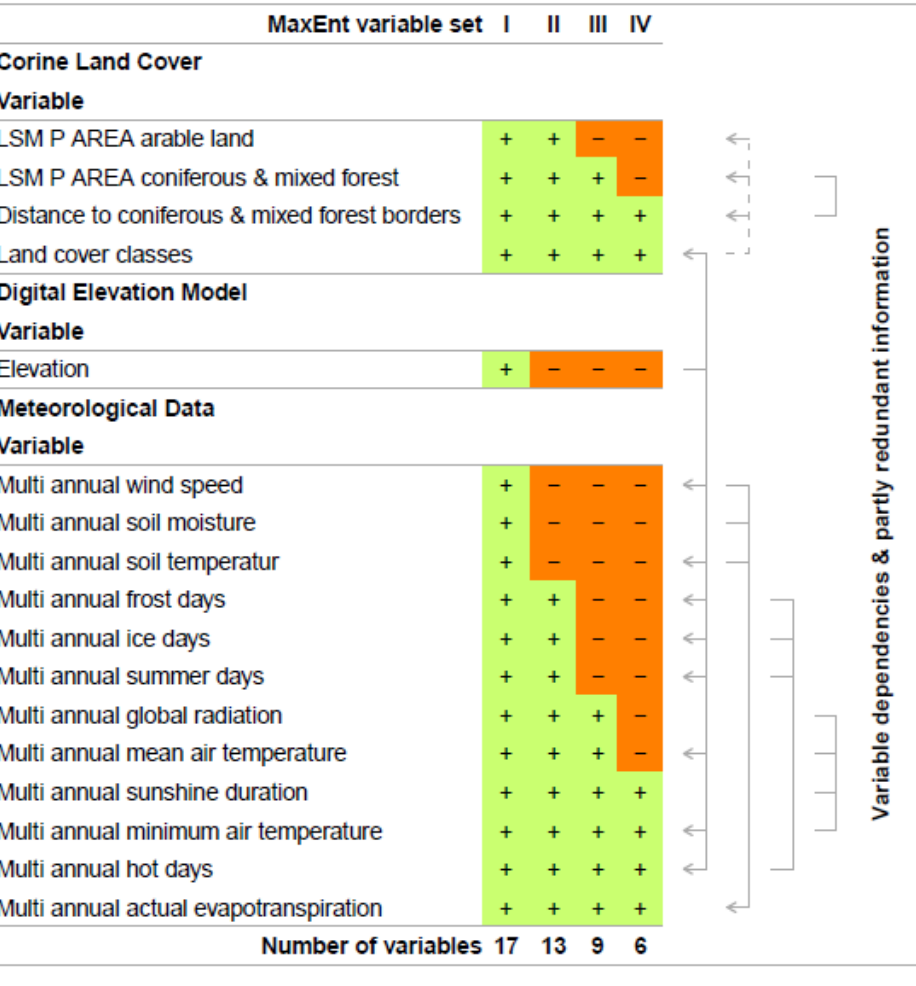
Figure 3. Environmental variables that were included in the MaxEnt model . The number of variables is step-by-step reduced to the final and most important six variables, which are used in the final run of the MaxEnt model.